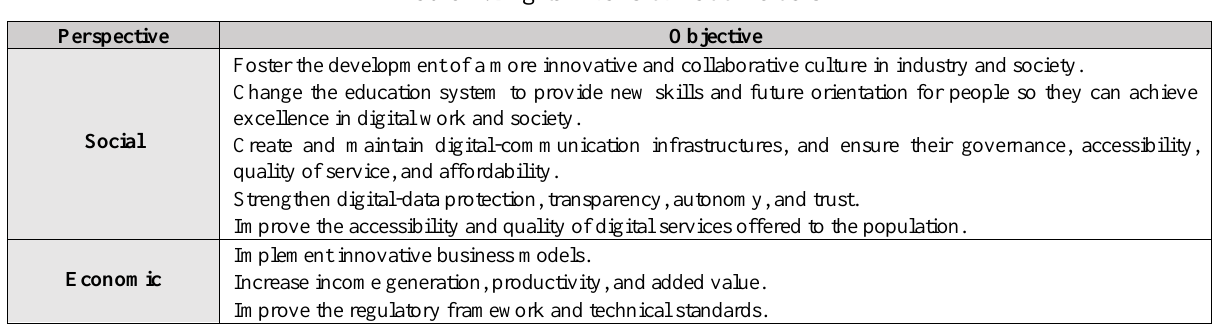
Table 1. Digital Transformation Goals